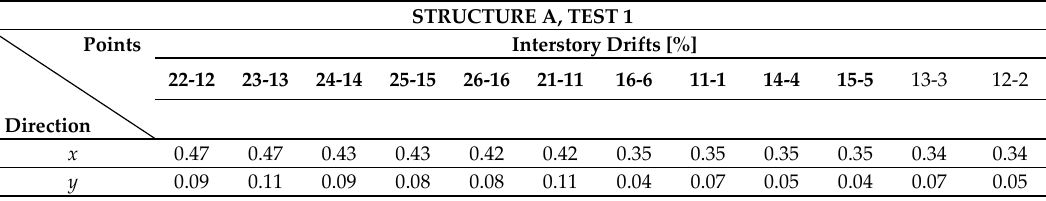
Table 9. Maximum Interstory Drift [%], seismic action 1, combination (100% x , 30% y).